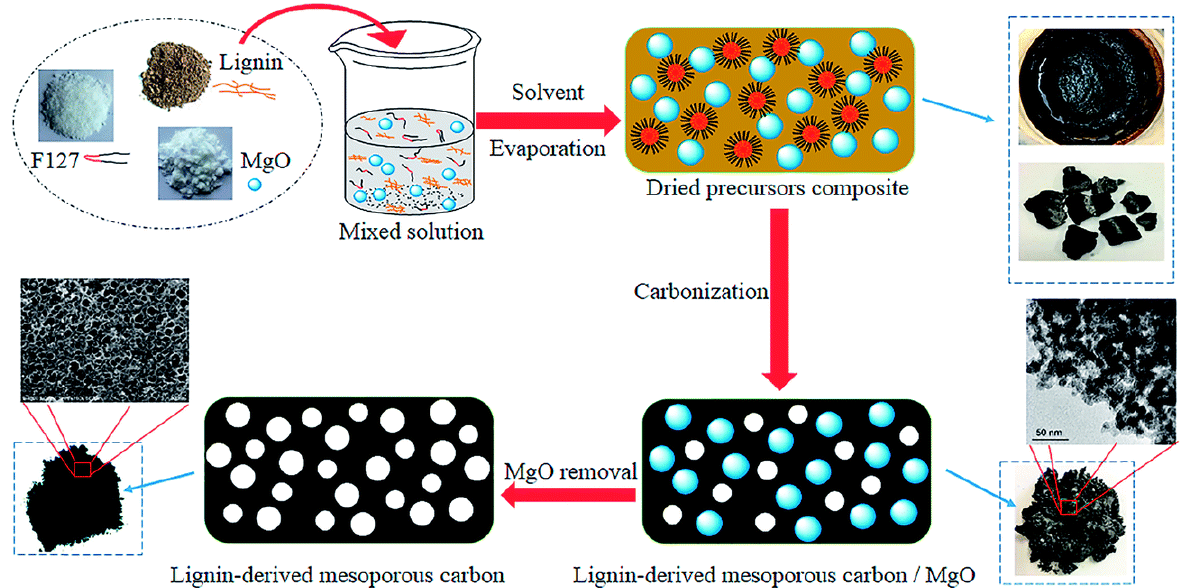
Figure 7. Schematic of lignin-derived mesoporous carbon via a dual-template strategy. Adapted from reference [37]. This article is an open-access article distributed under the terms and conditions of the Creative Commons Attribution (CC BY-NC 3.0) license. Table 1. Overview of electrode materials synthesized from biopolymer-based materials for superca- pacitor